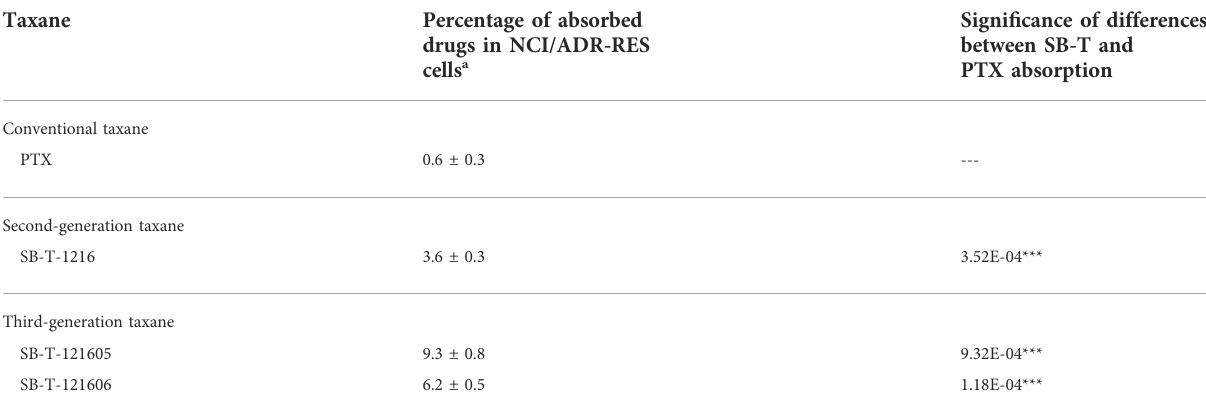
TABLE 1 Comparison of proportions of taxanes absorbed into NCI/ADR-RES ovarian cancer cells after 120 min incubation with 10 µM PTX, SB-T- 1216, SB-T-121605, and SB-T-121606 taxanes and their HPLC detection. Signi fi cant results are marked as: *** ( p ≤ 0.001).